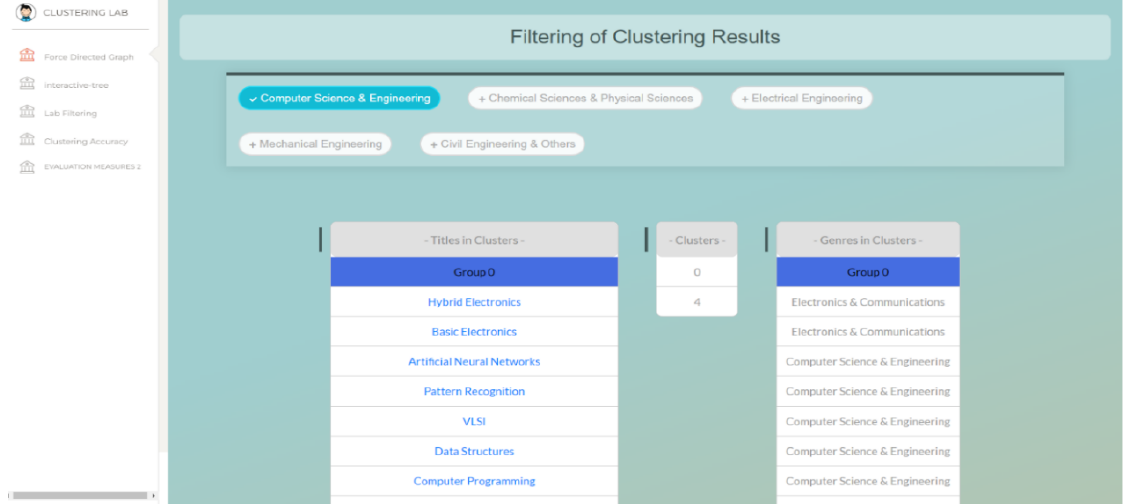
Figure 5. Figure 4. Optimal number of clusters for HAC algorithm using dendrogram.